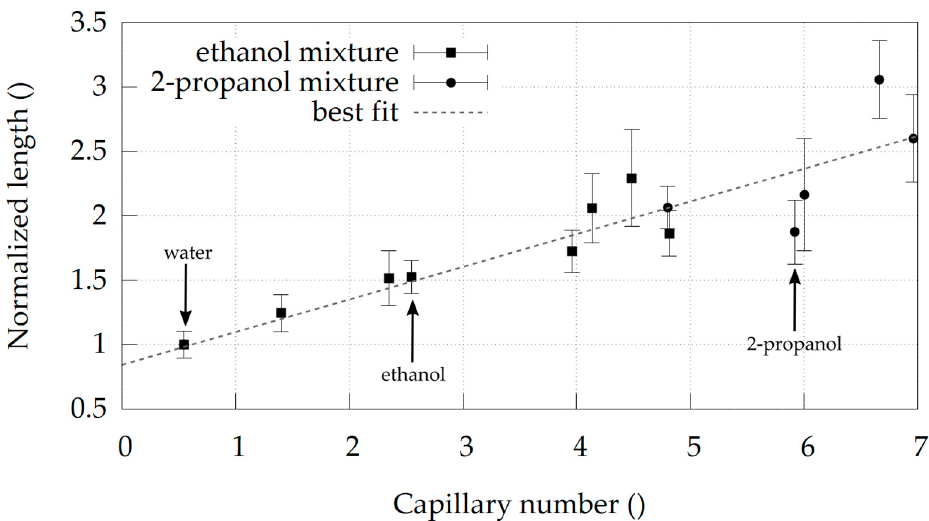
Figure 4. Normalized jet length as a function of capillary number. Black squares denote different water + ethanol mixtures, while black circles correspond to different water + 2-propanol mixtures. Pure liquids are marked with an arrow. The dotted line depicts the best linear fit to the available dataset.